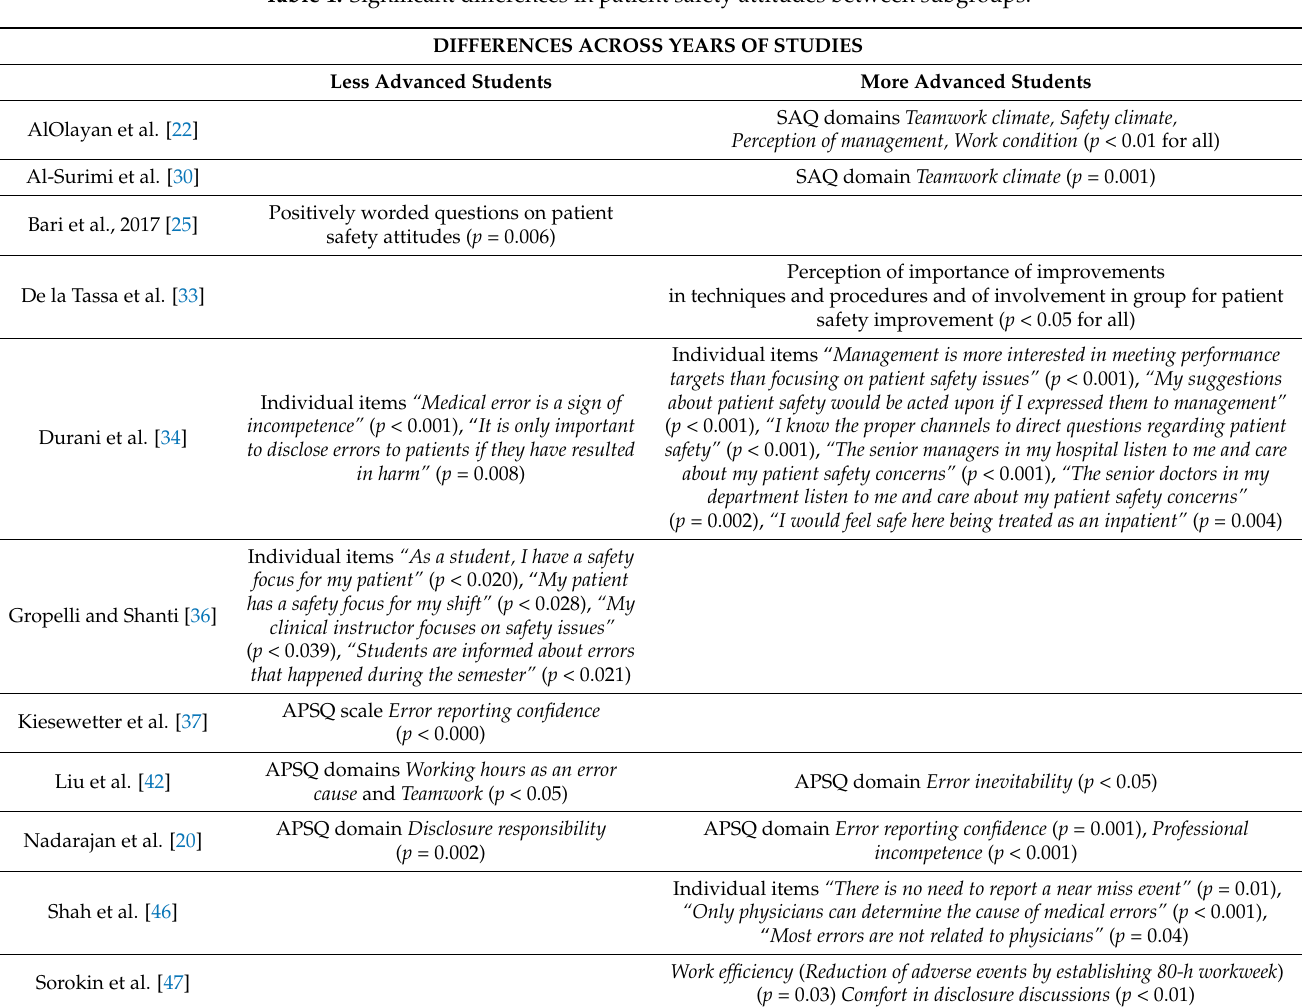
Table 1. Significant differences in patient safety attitudes between